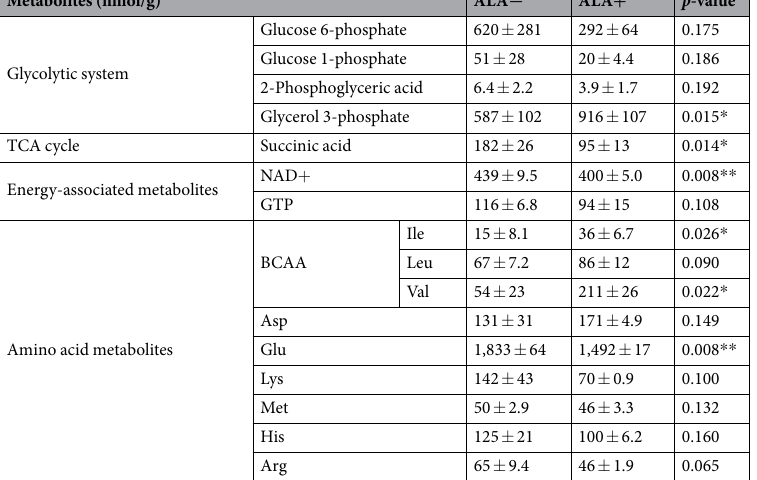
Table 1. Metabolome analysis of the metabolites in the quadriceps of ALA-treated mice. The quadriceps of control mice (ALA − ) and ALA-treated mice (ALA + ) were examined. The representative metabolites that had a p-value < 0.2 of the difference between ALA- and ALA + are shown. N = 3 in each group. * P < 0.05, ** P < 0.01 versus control groups. ALA, 5-aminolevlinic acid; TCA cycle, tricarboxylic acid; NAD, nicotinamide adenine dinucleotide; GTP, guanosine triphosphate; BCAA, branched chain amino acid; Ile, isoleucine; Leu, leucine; Val, valine; Asp, aspartic acid; Glu, glutamic acid; Lys, lysine; Met, methionine; His, histidine; Arg,